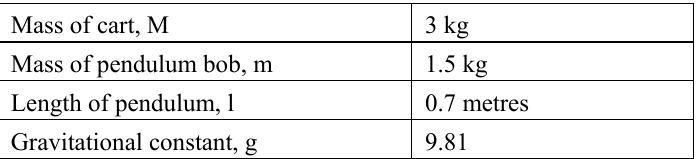
Table 7. Inverted pendulum